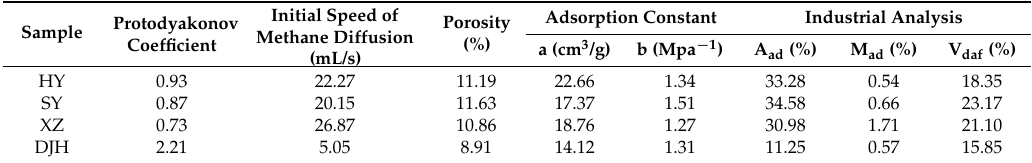
Table 1. Coal sample basic parameters.